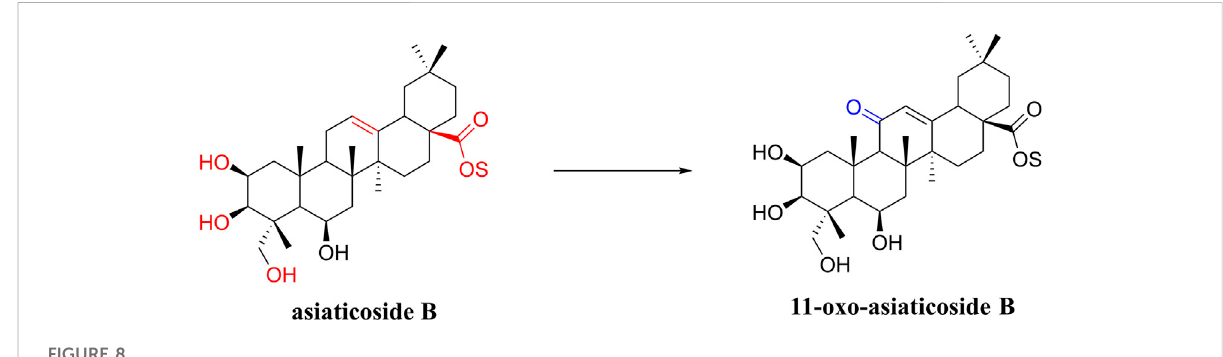
FIGURE 8 Asiaticoside B and its